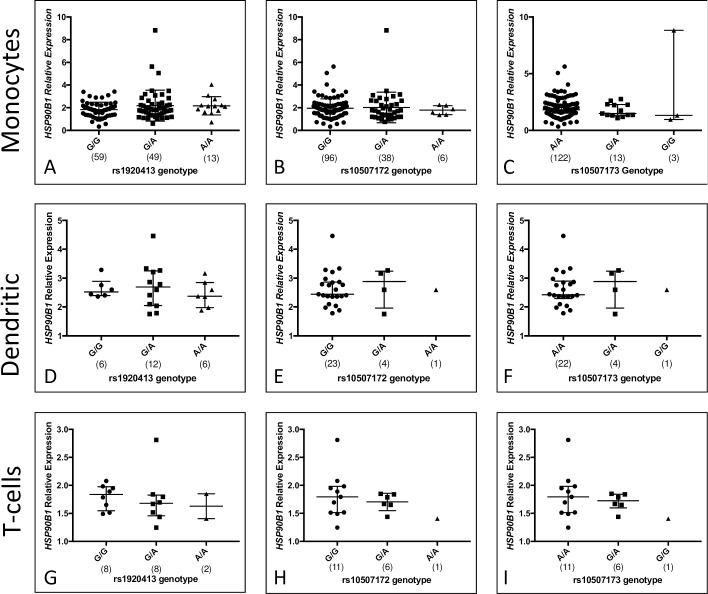
HSP90B1 variants are not associated with gene expression.HSP90B1 expression was compared to expression of GAPDH in unstimulated monocytes (A, B, C), dendritic cells (D, E, F), and T-cells (G, H, I) and stratified by genotype. Median and interquartile ranges are included and sample sizes are provided in parentheses below each genotype. Results for select SNPs are shown. Results were not significant for any of the SNPs evaluated (p>0.05, ANOVA).